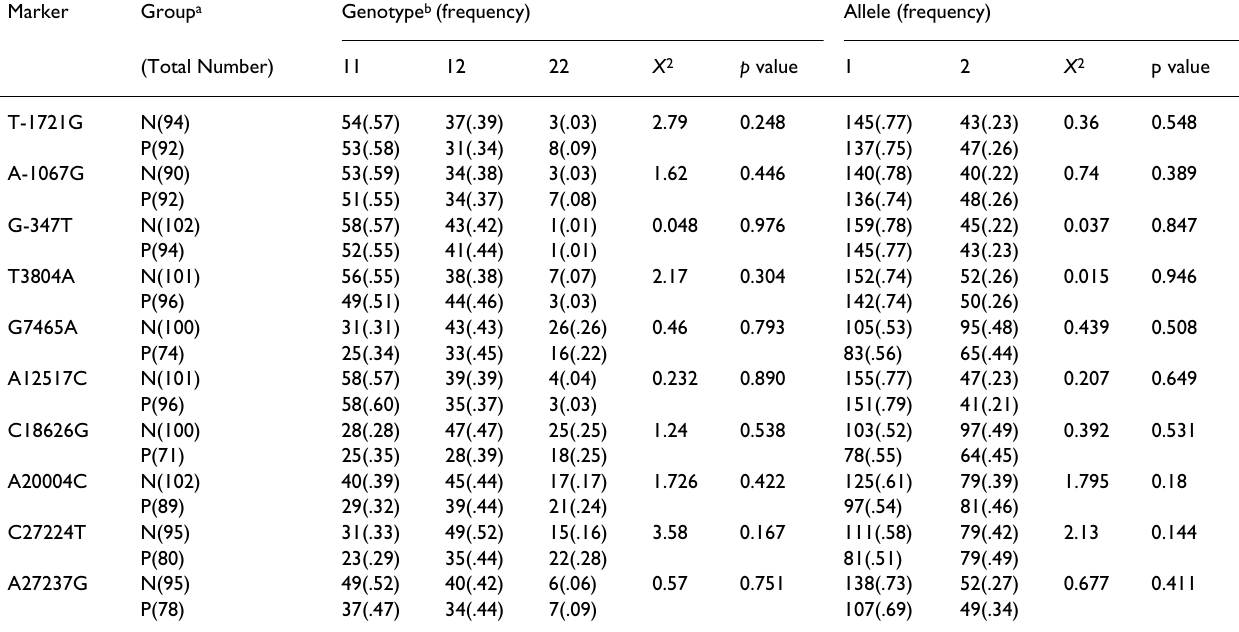
Table 2: Genotype and allele frequencies of the TPH1 gene polymorphisms. Marker Group